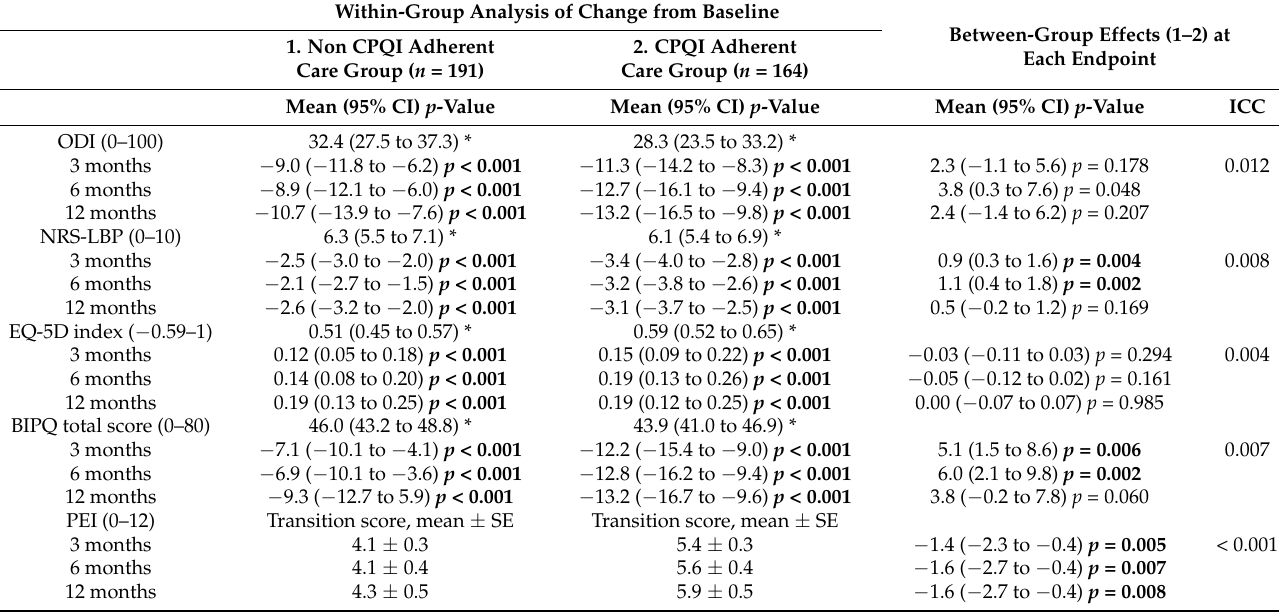
Table 6. Comparisons of patient reported outcome measures for patients receiving CPQI adherent/non adherent care. Within-Group Analysis of Change from Baseline Endpoint1. Non CPQI Adherent